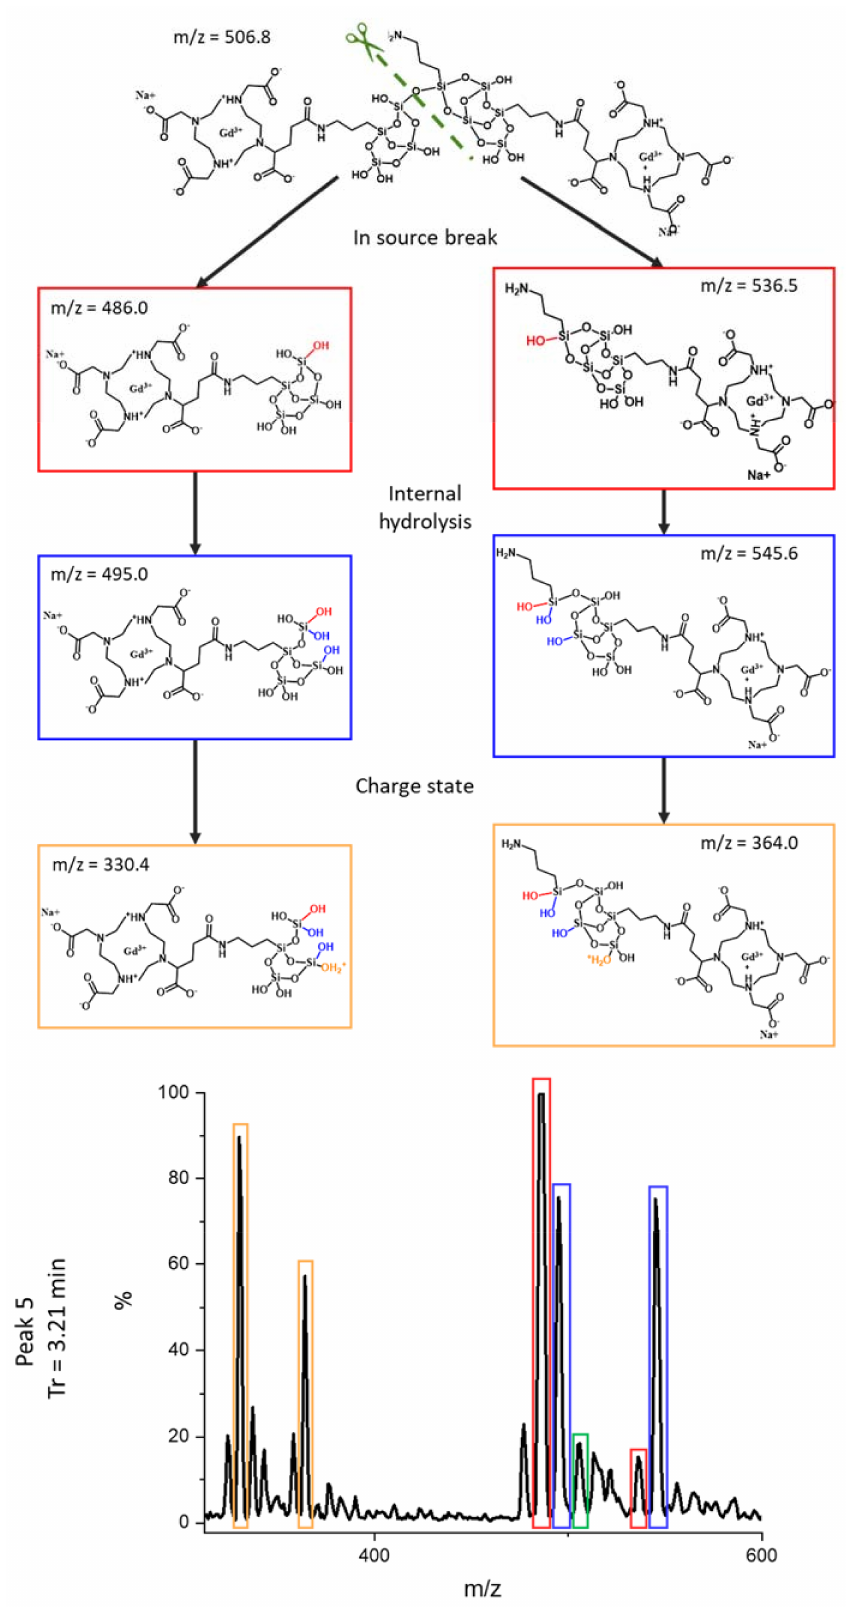
Figure 4. Stucture of the main chemical compound detected on peak 5 (Tr = 3.21 min) and of the related species issued from the hydrolysis of the Si–O–Si